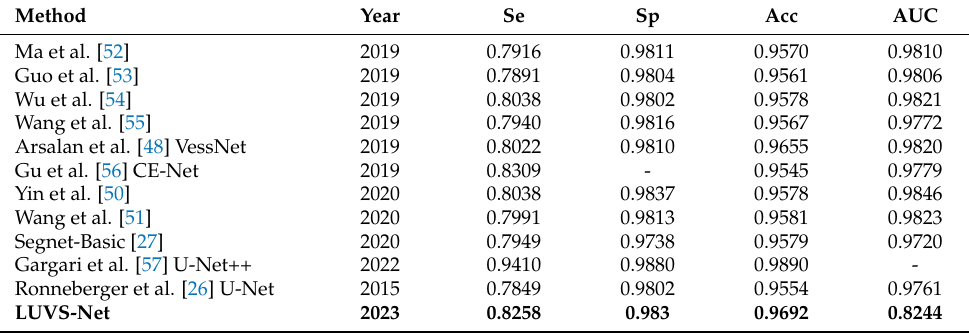
Table 6. LUVS-Net compared to existing models as tested (dataset: DRIVE).